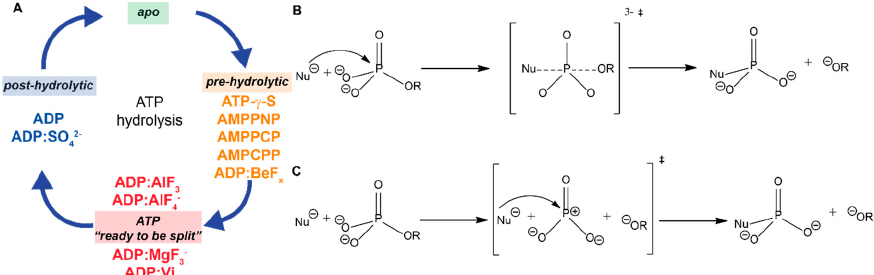
Table 1. Overview of magnetic-resonance techniques applied in this work and information extracted. A cross indicates that this information is contained in the experimental outcome, a blank indicates that the type of extracted information is not accessible by the